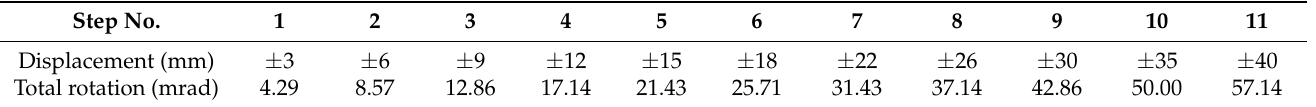
Table 3. Cyclic loading history applied to free end of